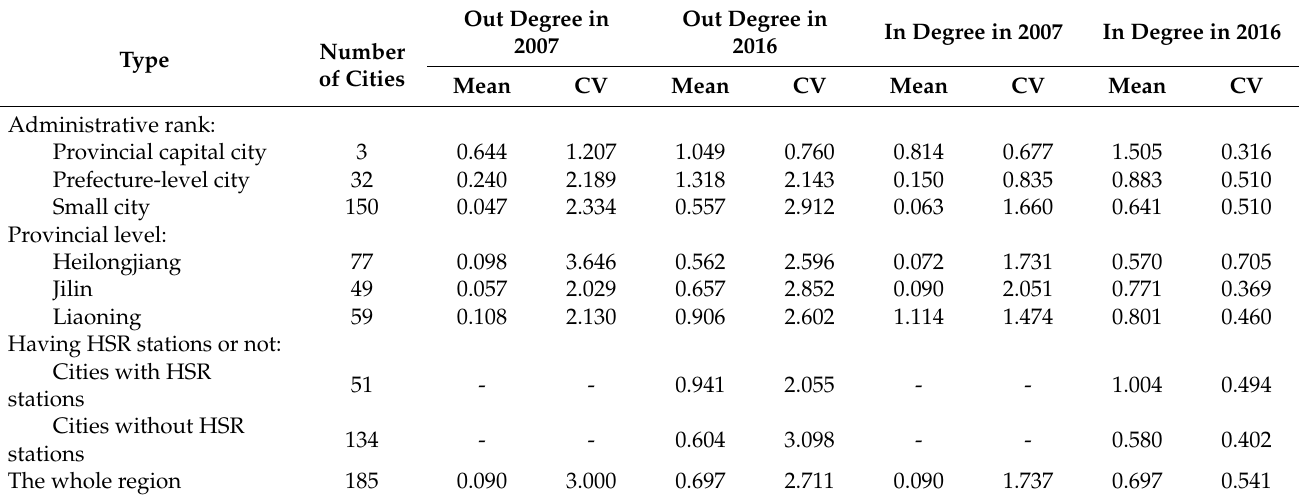
Table 3. Normalized out-degree and in-degree centrality in 2007 and